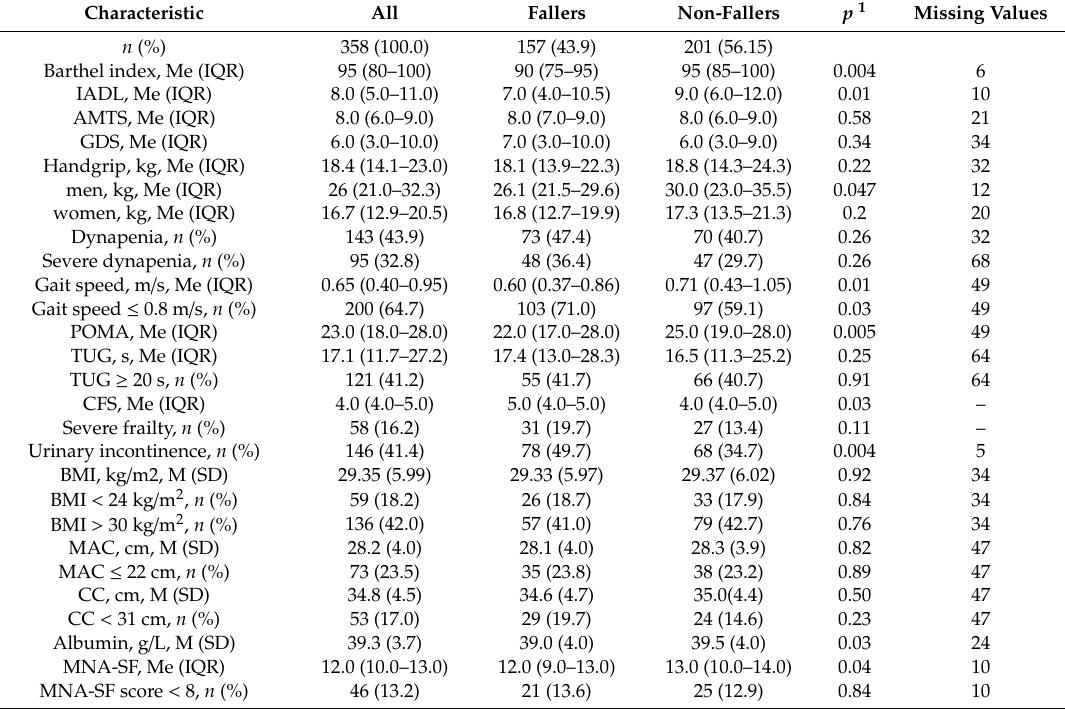
Table 2. Characteristics of study participants—functional and nutritional correlates of